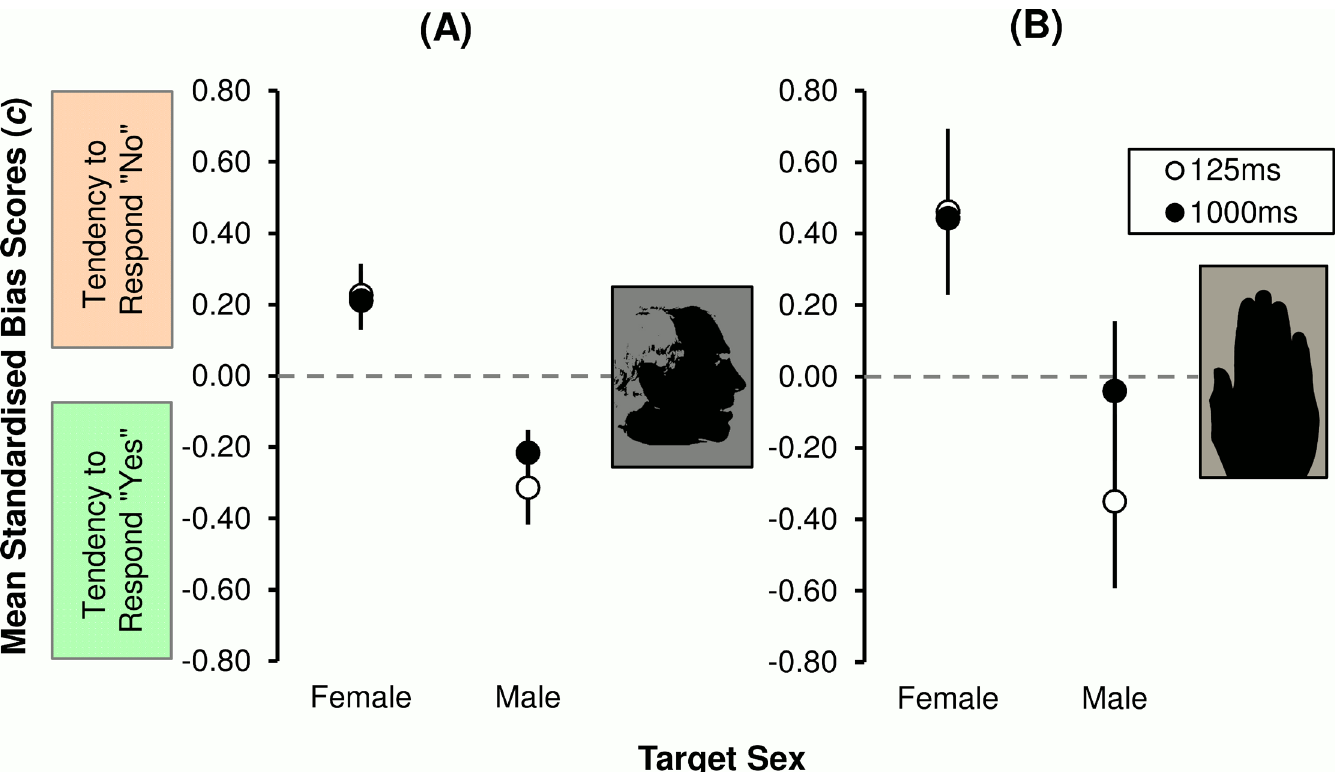
Fig 8. Caucasian observer sex discrimination bias for own-race hand images. Standardised bias ( c ) scores corresponding to two Caucasian, own-race observer groups: ( A ) silhouette face observers from the current study, and ( B ) silhouette hand observers from Gaetano et al. [12]. Performance is plotted as a function of target sex (female, male) and presentation duration (125 ms, 1000 ms); in each condition, there was an equal prior target probability, and hands were presented without hue or texture information. Vertical bars represent ± 1 SEM